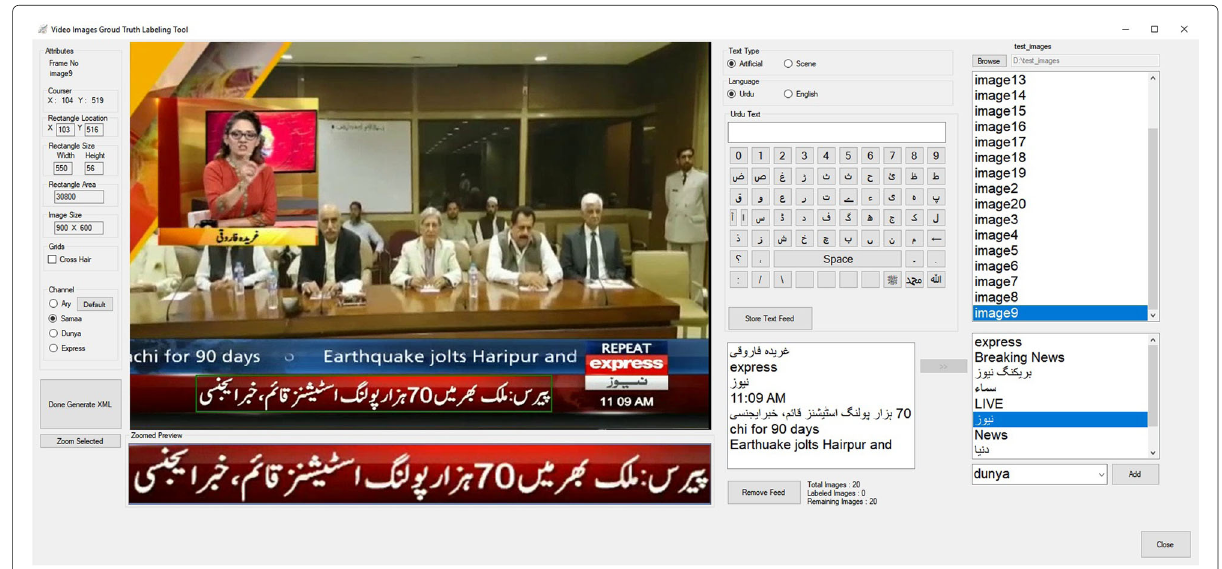
Fig. 4 Screenshot of ground truth labeling